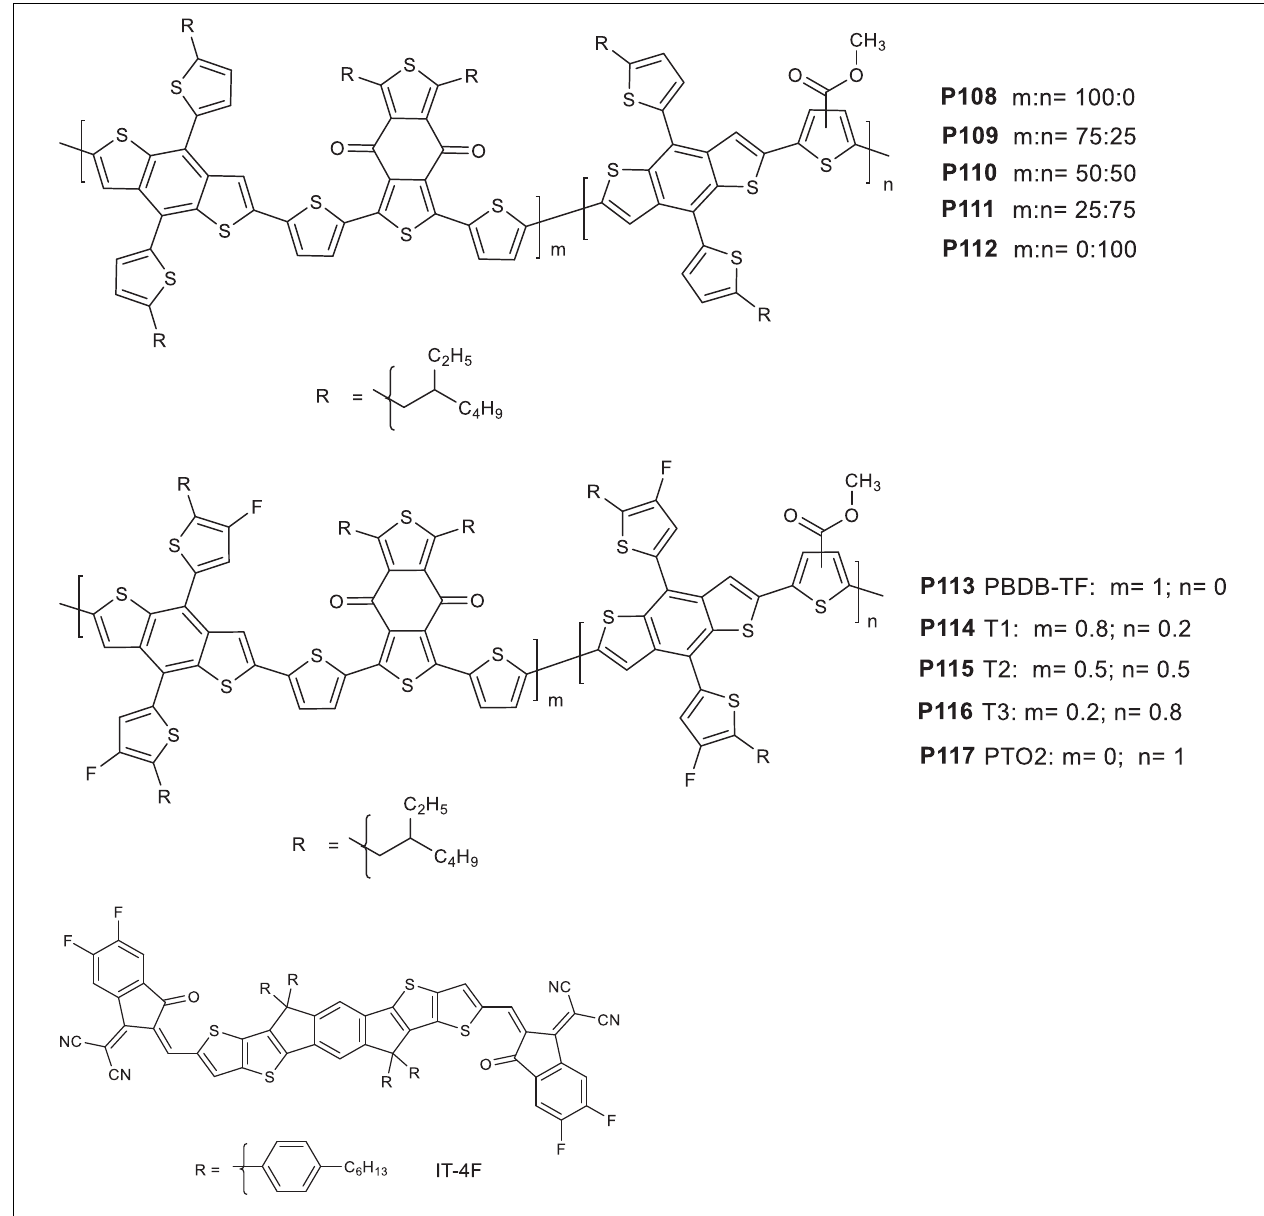
FIGURE 9 | Donor polymers based on benzodithiophene-dione (BDD) used as one of the acceptors ( P95 – P107 ) and IT-4F.